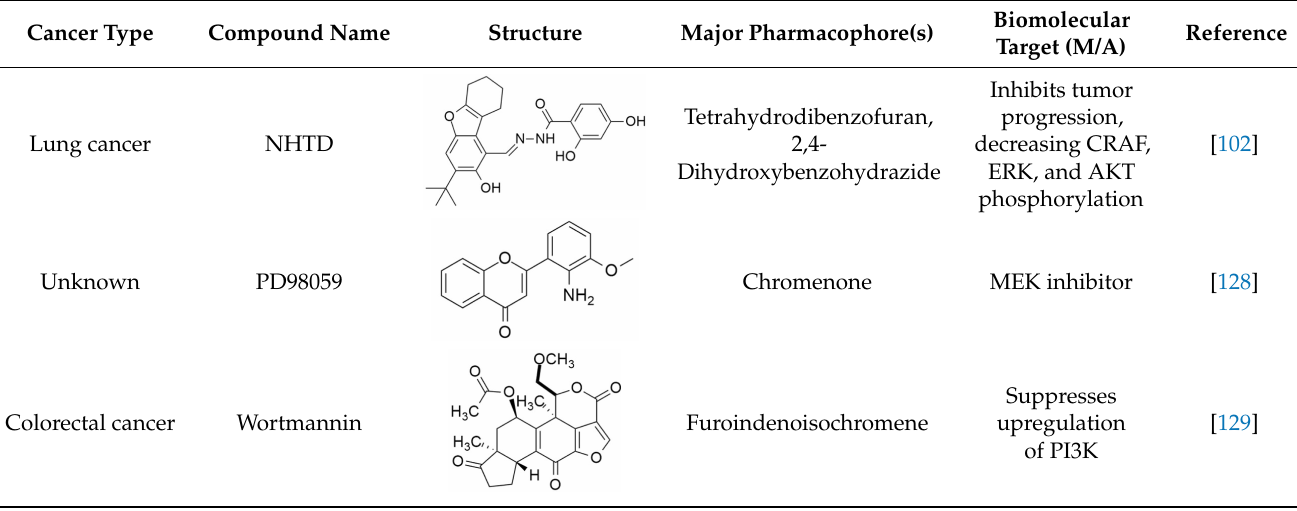
Table 3. Oxo heterocyclic small-molecule RAS